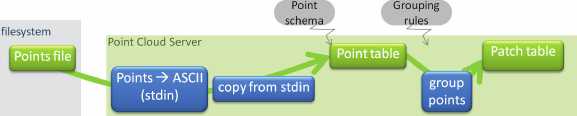
Figure 2: Simplified schema for ”Server reads” data loading